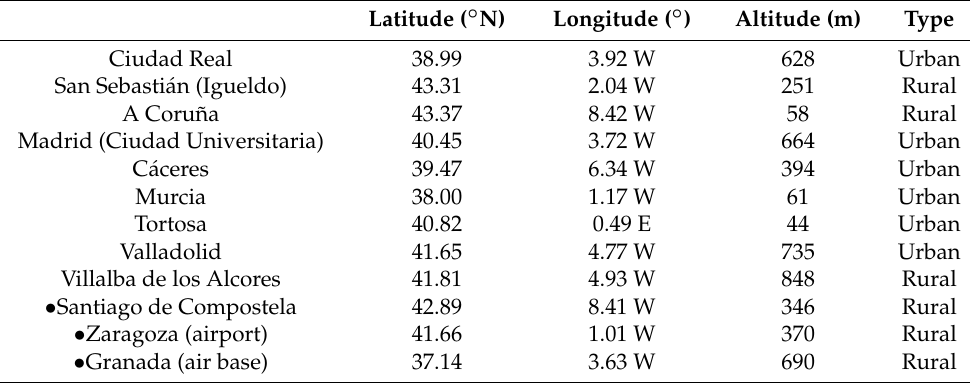
Table 1. Geographical characteristics of the stations for the present study. The first nine stations were used to calculate the Iberian Peninsula (IP) time series. ( • ) mean rural